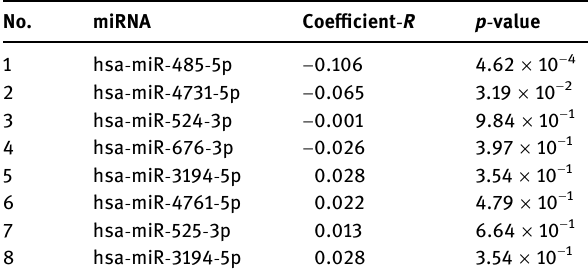
Table 3: Correlation of miRNA - LIG1 pairs identi fi ed by the ENCORI database